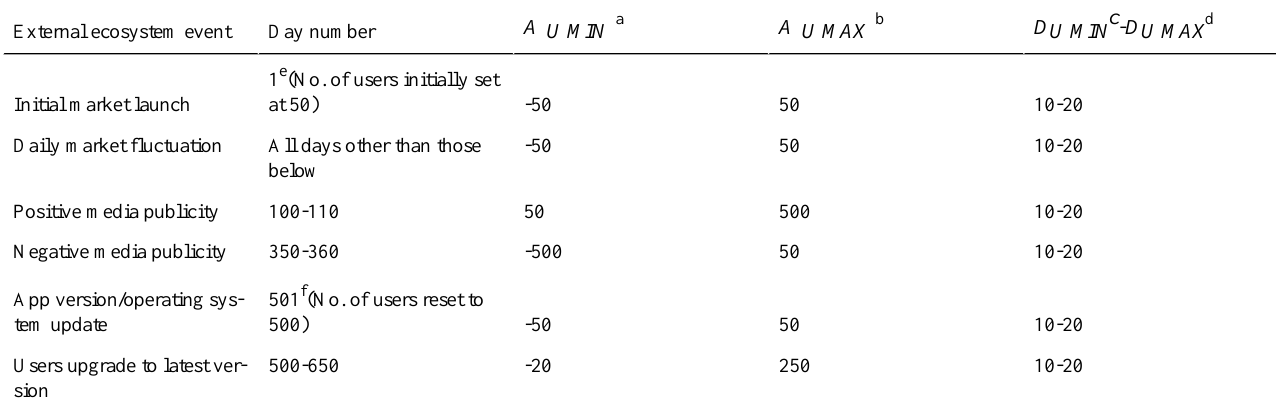
Table 3. Initial data used to model the characteristics of the AUF as a function of time for a single mobile app.